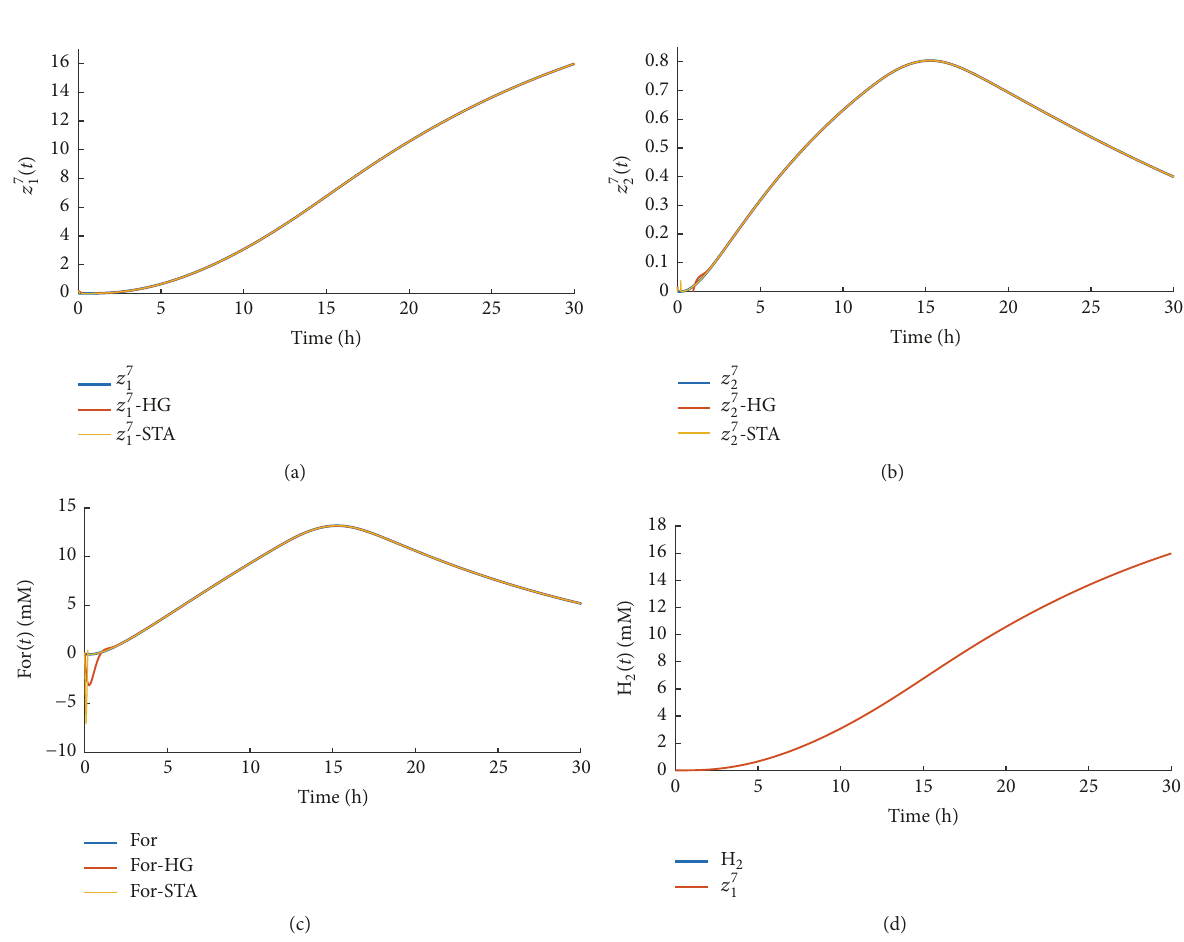
formate and hydrogen. Even when these trajectories corre- spond to the most simple subsystem, the superior perfor- mance of the STA-based observer is conserved. Even when both observers converge in less than one hour, the STA-based observer did it within the first half